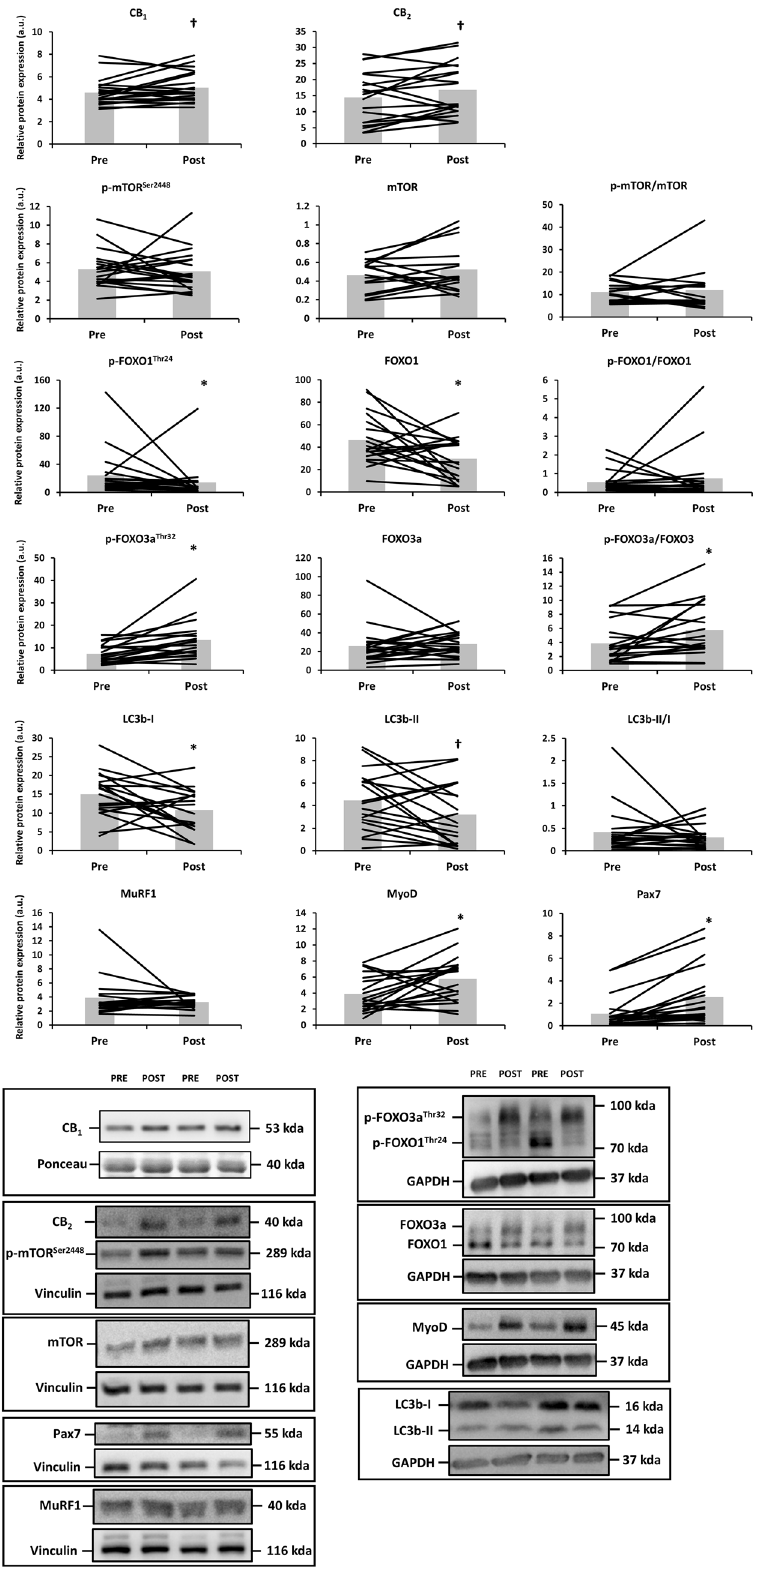
Figure 2. Differences in the protein expression of cannabinoid receptor 1 (CB 1 ), CB 2 , phospho and total mammalian target of rapamycin (mTOR) at Ser2448, phospho and total forkhead box O (FOXO)1/3a at Thr24/32, microtubule-associated protein 1A/1B- light chain 3 (LC3b), muscle RING finger-1 (MuRF1), MyoD and Pax7 before (Pre) and after (Post) resistance exercise in old adults (n = 19). Protein targets were normalized to glyceraldehyde 3-phosphate dehydrogenase (GAPDH), vinculin or the total protein form. Data are shown as mean (bar graph in grey) with individual data points (black lines superimposed on the bar graphs). *p < 0.05 and † p = 0.05–0.10 for Paired-Samples t Test or Wilcoxon signed-rank test. Raw western blot data of all replicates are displayed in Supplementary Figure 4. Ponceau red staining of the presented western blots are included in Supplementary Figure